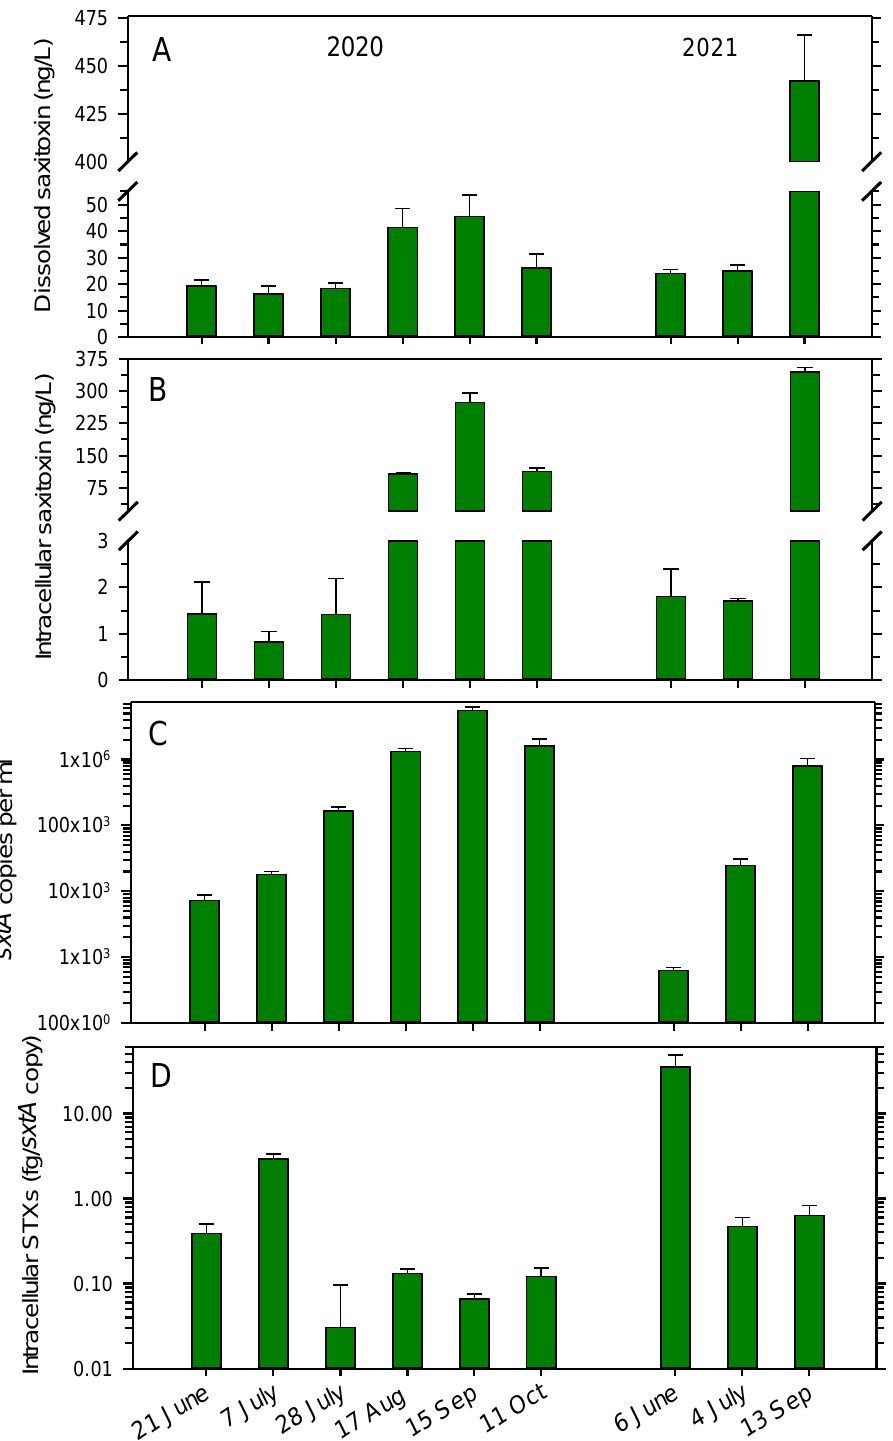
Figure 1. Distribution of saxitoxin (STX) in Lake Arresø in 2020 and 2021. ( A ) Concentrations of dissolved, extracellular STX in lake water; ( B ) concentrations of intracellular STX; ( C ) copy number of the sxtA gene; ( D ) concentration of intracellular STX per sxtA copy number. STX was quantified by HPLC detection. Means ± 1 STD are shown ( n = 3).